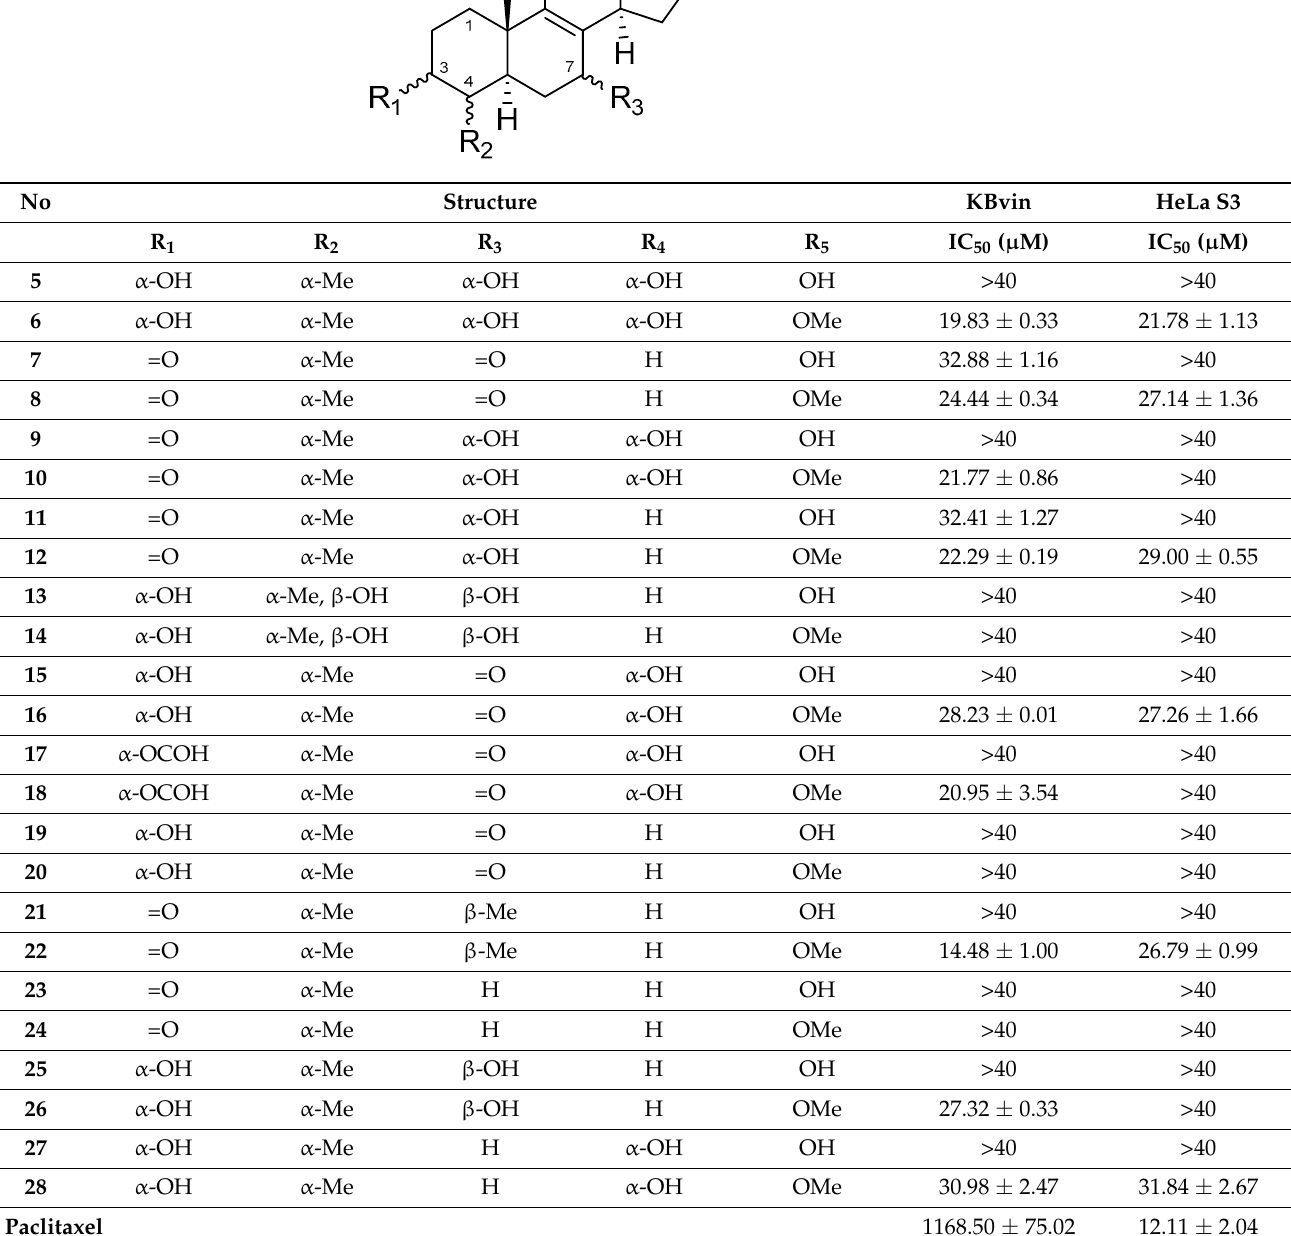
Table 2. Cytotoxicity IC 50 of 5 – 28 compounds.